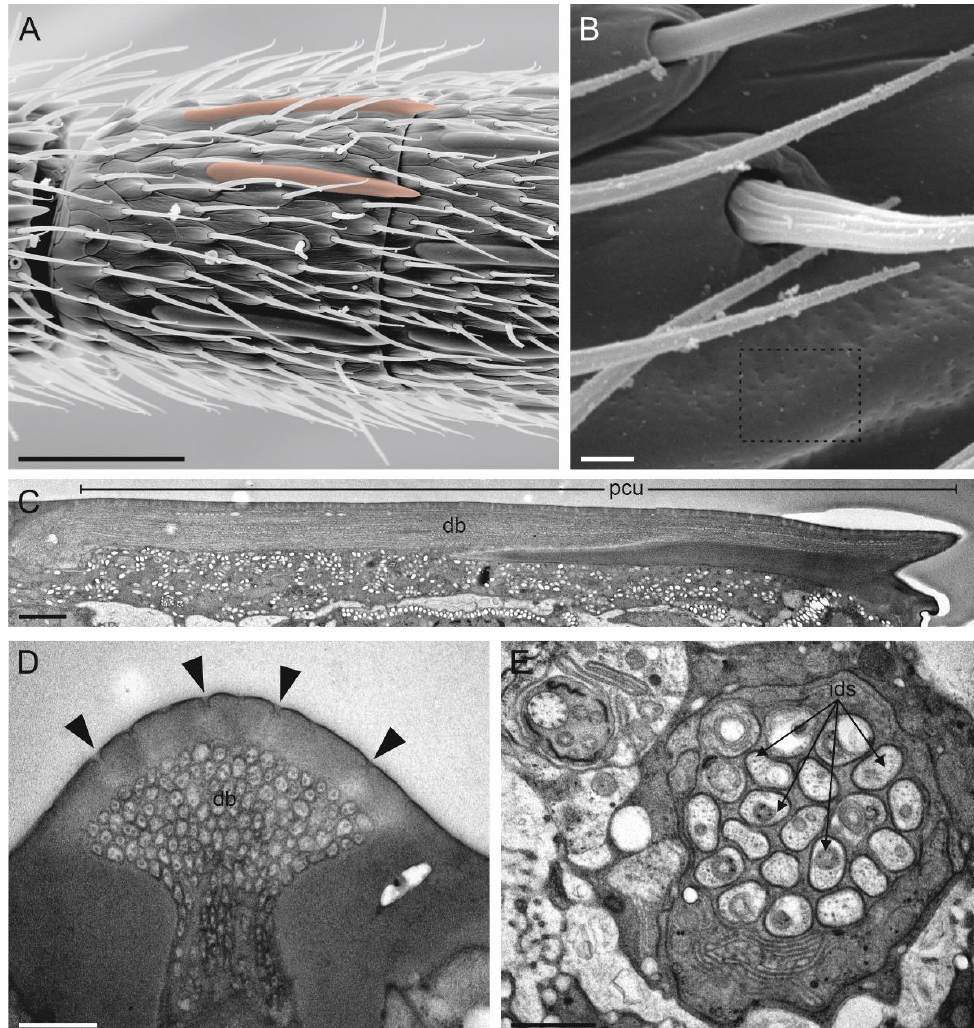
Figure 6. ( A ) SEM picture of the proximal part of F7 in dorsal view, where two multiporous plate sensilla (MPS) can be observed (red mask). ( B ) Detail of the porous cuticle (dotted square). ( C ) TEM image obtained combining 7 adjacent pictures, showing a longitudinal section of an MPS. A large amount of dendrite branches (db) completely fills the space below the porous cuticle (pcu). ( D ) TEM cross-section of an MPS taken approximately at the third distal length form the tip, showing the cuticular pores (black arrowheads) and the dendrite branches (DB). ( E ) TEM cross-section showing the bundle of 20 inner dendritic segments (ids) belonging to the sensory neurons innervating a single MPS. Scale bar: ( A ): 30 µm; ( B , E ): 1 µm; ( C ): 2 µm; ( D ): 0.5 µm.